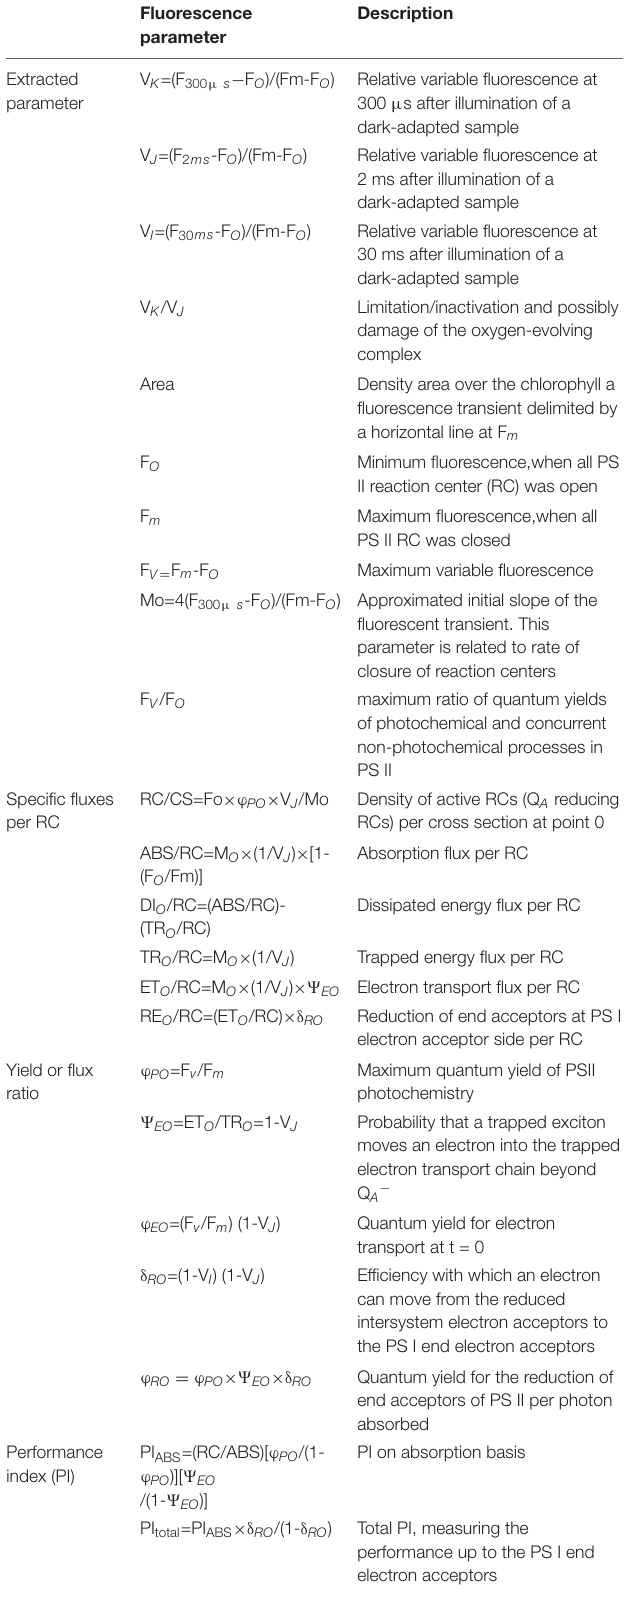
TABLE 1 | Kinetic parameters of chlorophyll fluorescence. Fluorescence parameter